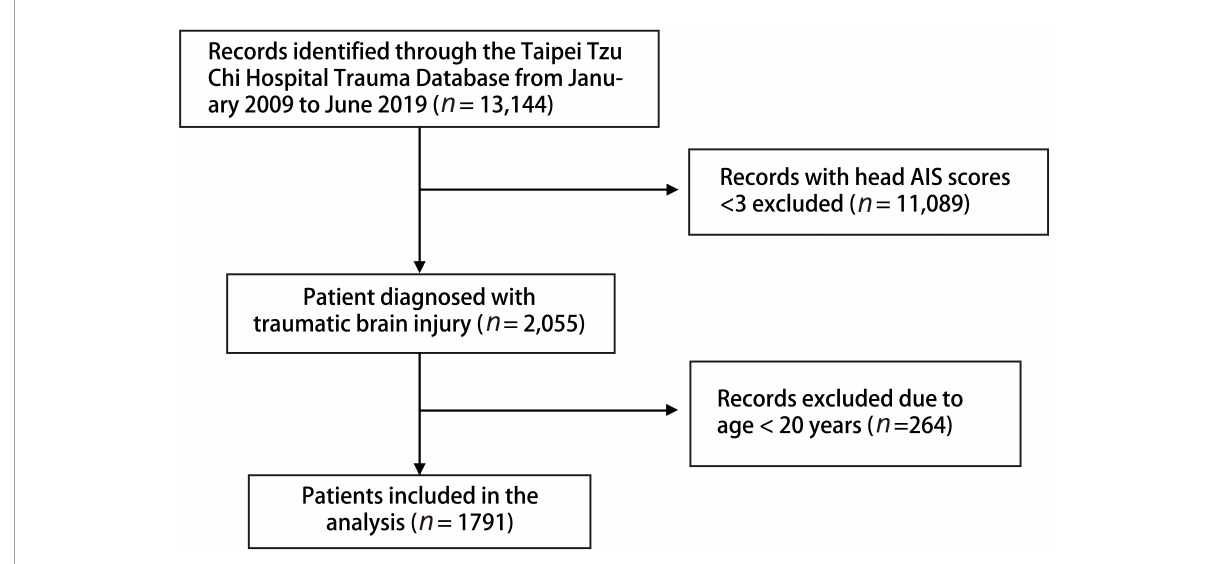
FIGURE1 Flow diagram of patients included in our